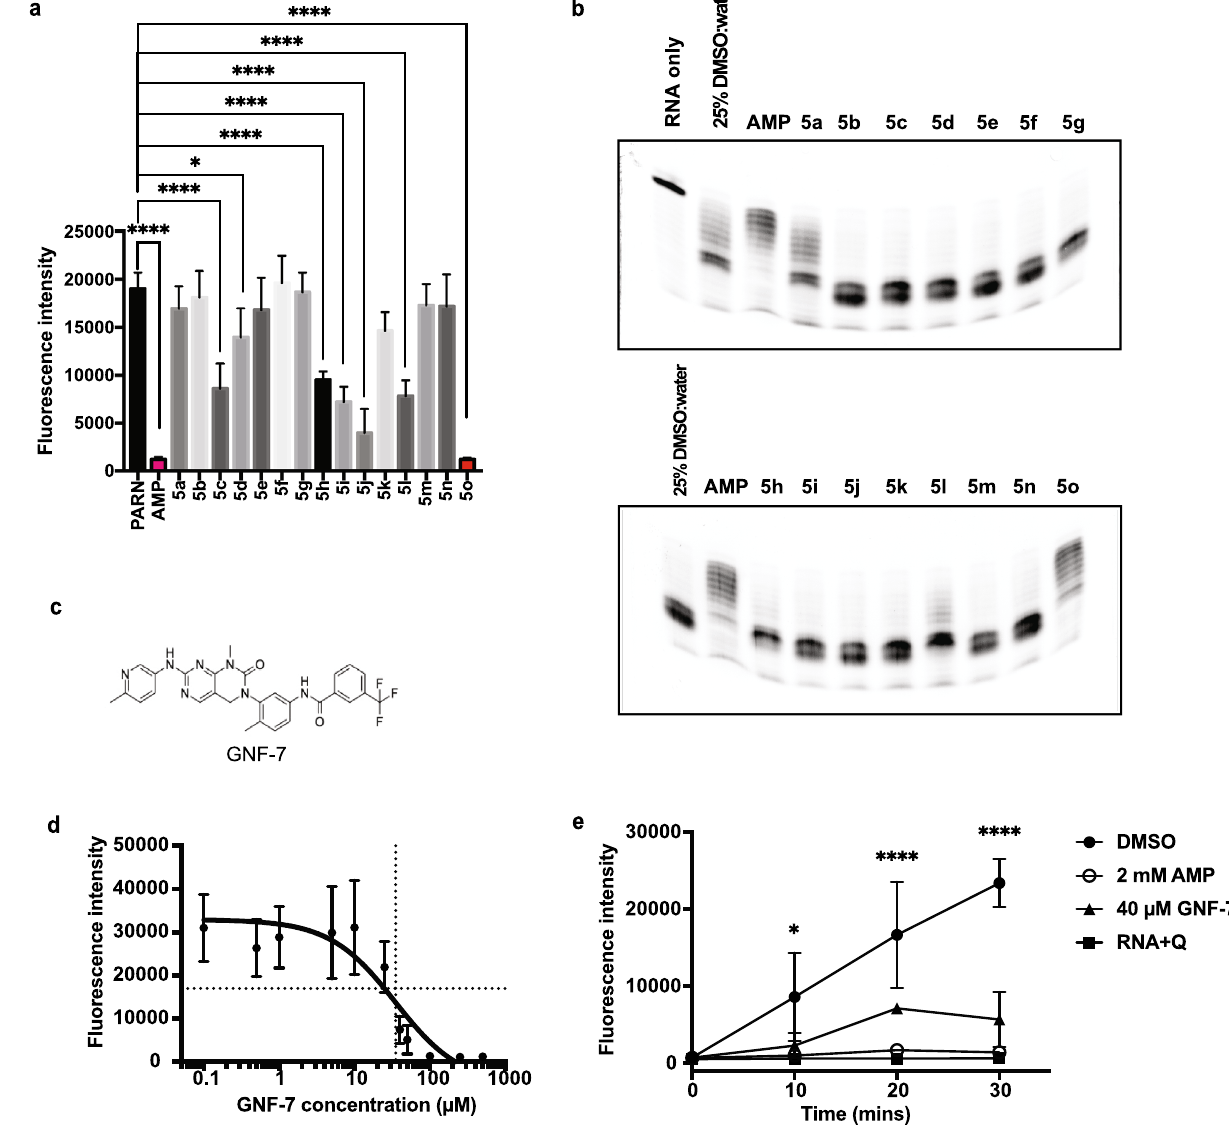
Figure 5. Testing drugs on activity of PARN using RNA substrates in vitro. ( a ) Inhibition fluorescence assay showing effects of different drugs on PARN 1-430 . PARN 1-430 was pretreated with drugs at room temperature for 10 min before adding RNA substrate. AMP and GNF-7 were shown in pink and red, respectively. One- way ANOVA, multiple comparisons test, average ± SD, n ≥ 3 replicates. *P < 0.05, **P < 0.005, ***P < 0.001, ****P < 0.0001, n.s. was not indicated. ( b ) Gels illustrating inhibitory effects of different drugs on PARN 1-430 . The reaction was performed the same as the fluorescence assay, heat inactivated, then loaded and visualized on gels. Full gels are presented in Supplementary Fig. S1. ( c ) Molecular structure of GNF-7. ( d ) Dose–response curve of GNF-7 on PARN 1-430 . PARN 1-430 was pre-treated with different concentrations of GNF-7 for 10 min and incubated with RNA substrate. The reaction was quenched with DNA quencher and fluorescence intensity was measured. The IC50 was determined to be 35 ± 15 μM. The vertical dotted line marks the fitted IC50 of GNF-7 and the horizonal dotted line marks 50% inhibition. ( e ) Kinetic analysis of AMP and GNF-7 effects on PARN 1-430 and a no-enzyme control. Pretreated PARN 1-430 was incubated with RNA substrate for 0, 10, 20, and 30 min and the fluorescence intensity were measured at each time point. 2-way ANOVA, multiple comparisons, average ± SD, n = 3 replicates. *P < 0.05, **P < 0.005, ***P < 0.001, ****P < 0.0001, n.s. was not